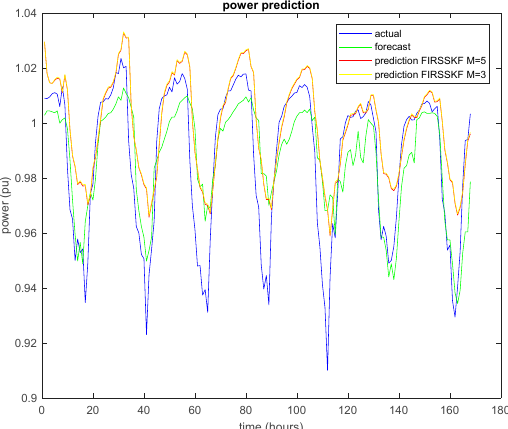
Figure 7. Power generation prediction with FIRSSKF using the linear model.